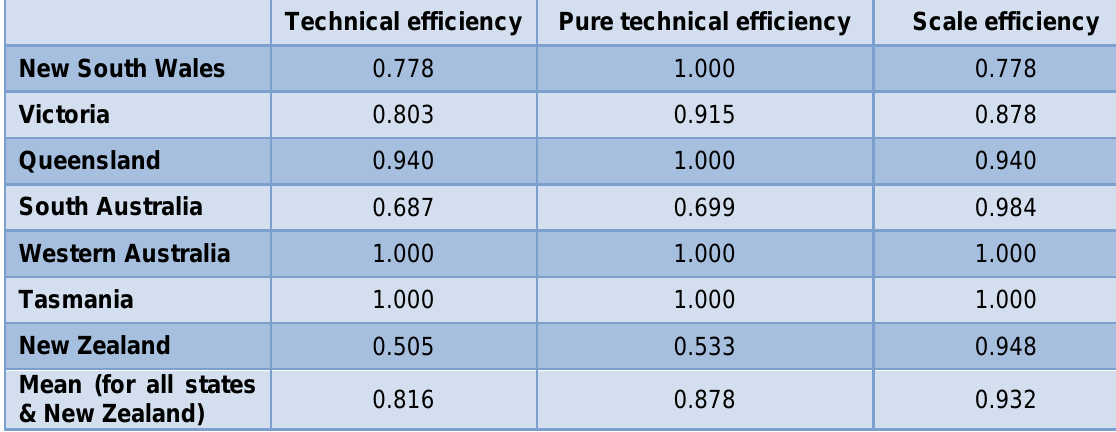
Table 4 Efficiency levels 1991-2010 Australian and New Zealand jurisdictions (output=value added; inputs=labour & capital stock)